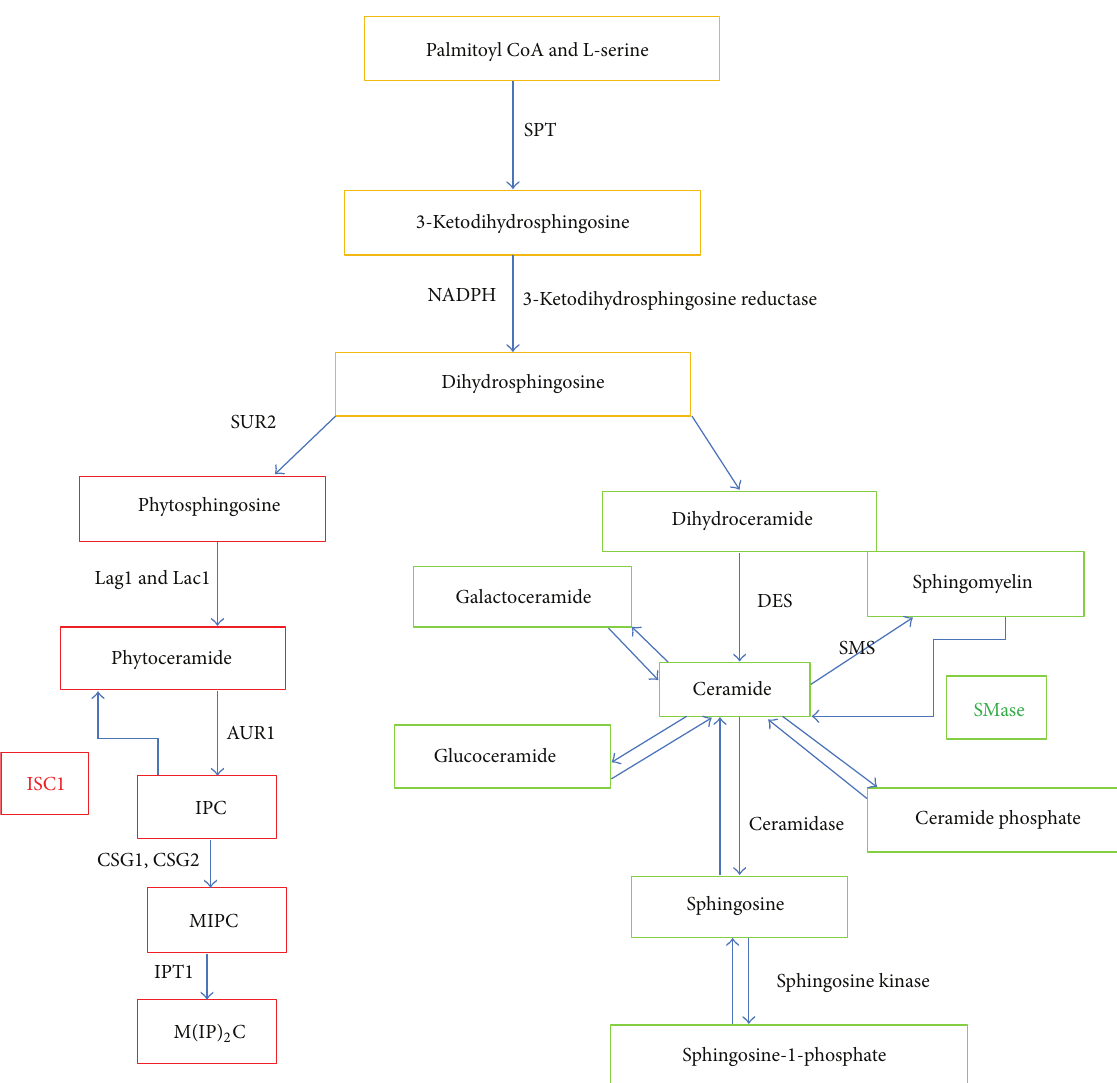
Figure 1: The flow diagram represents the sphingolipid metabolism pathways both in mammals and in yeast. The common steps in both the organisms are shown in yellow boxes. The yeast sphingolipid metabolism pathway steps are shown in red boxes while mammals pathway are shown in green boxes; the positions of sphingomyelinase (SMase) and inositol phosphosphingolipid phospholipase C1 ( ISC1 ) are shown in green and red letters,